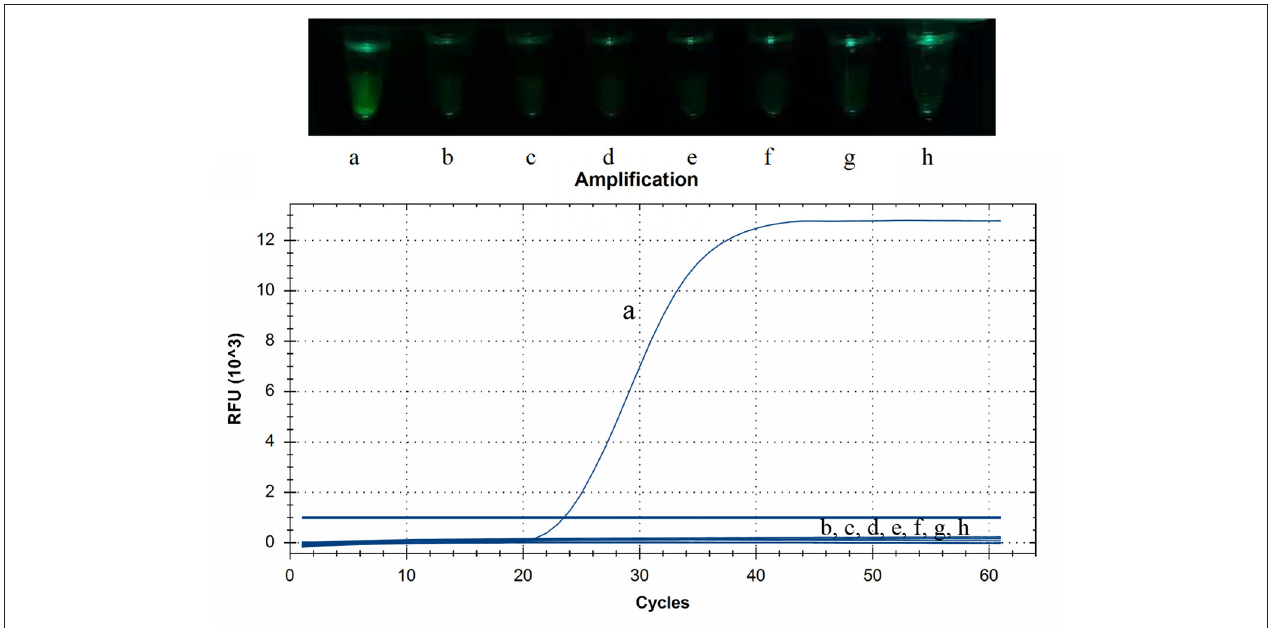
FIGURE 3 | Specificity of cleaved probe-based reverse transcription loop-mediated isothermal amplification (CP-RT-LAMP) assay. Specificity was tested using the genomic RNAs or DNAs of the following viruses: (a) porcine deltacoronavirus, (b) porcine epidemic diarrhea virus, (c) transmissible gastroenteritis virus of swine, (d) porcine reproductive respiratory syndrome virus, (e) classical swine fever virus, (f) swine acute diarrhea syndrome coronavirus, (g) pseudorabies virus and (h) porcine circovirus type 2.